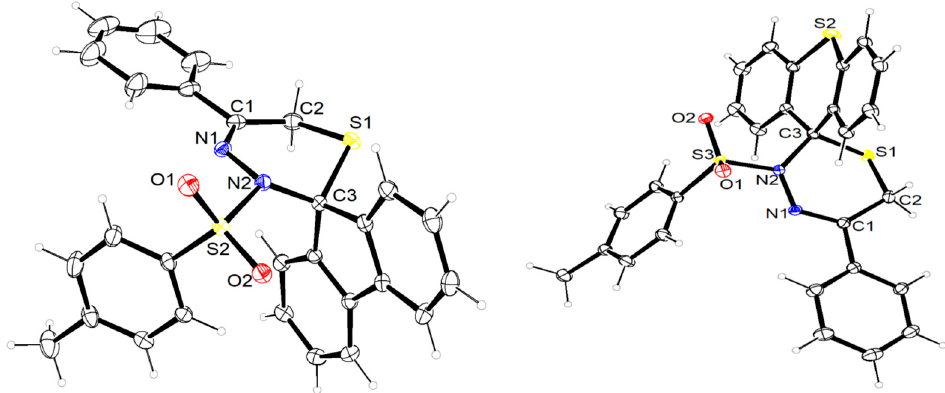
Figure 2. ORTEP Plots [34] of the molecular structures of compounds 9c ( left ) and 9g ( right ). Displacement ellipsoids are drawn at the 50% probability